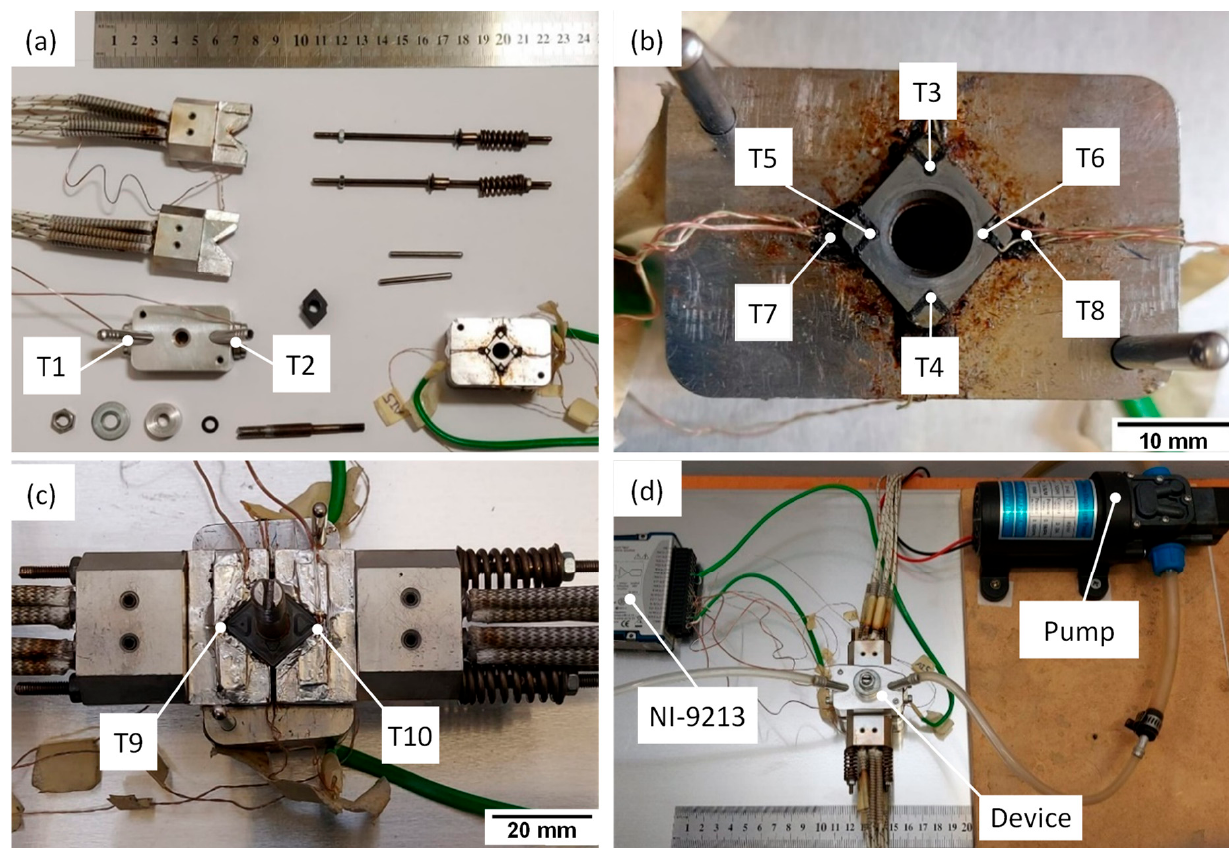
Figure 5. Experimental device images: ( a ) laid out components; ( b – d ) assembly main steps.